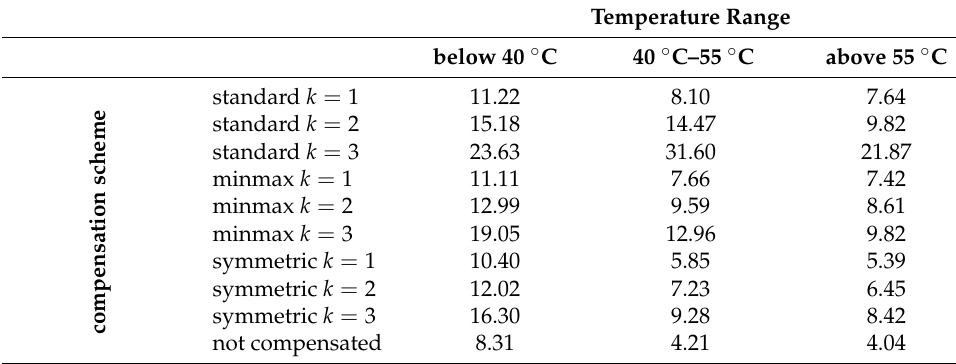
Table 3. D ef f coefficient for divAmp damage index obtained for specimen no. 1.